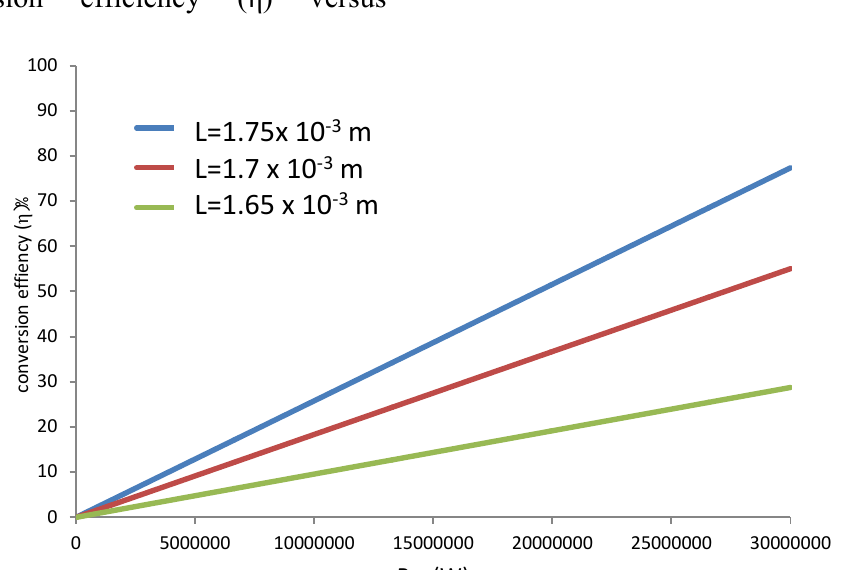
Fig. 4: Modeling resulting of efficiency (η) as a function of pumping power (P